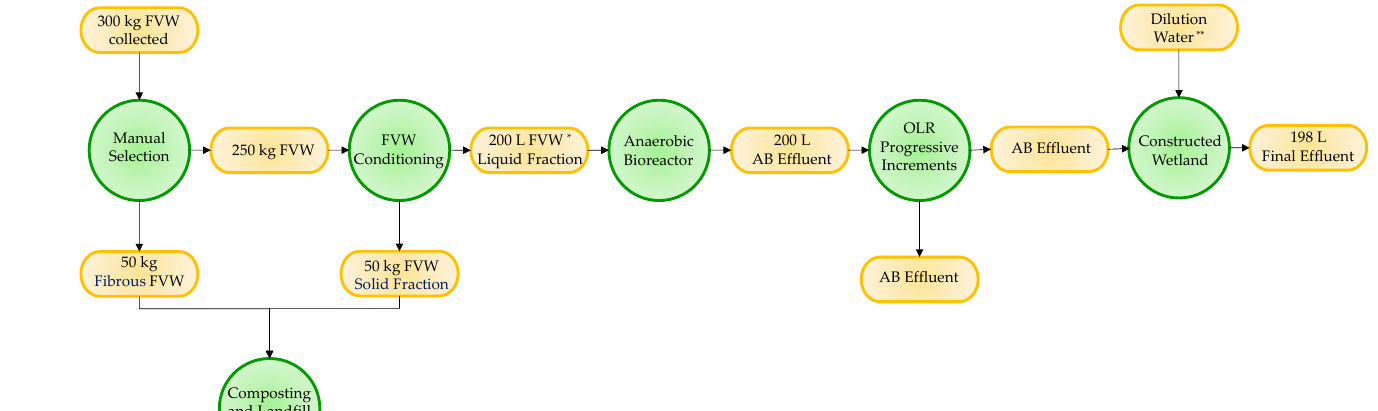
Figure 1. General sections of the hybrid methodology for the co-treatment of FVW. * From the fractions obtained by conditioning: 1 kg of FVW equals 77% of FVW liquid fraction i.e., 1 L adding solubilization water (Alvarado-Lassman et al., 2016) [39]. ** See Figure in Section 2.4 Hydraulic regimes and organic loading rates for the CW.